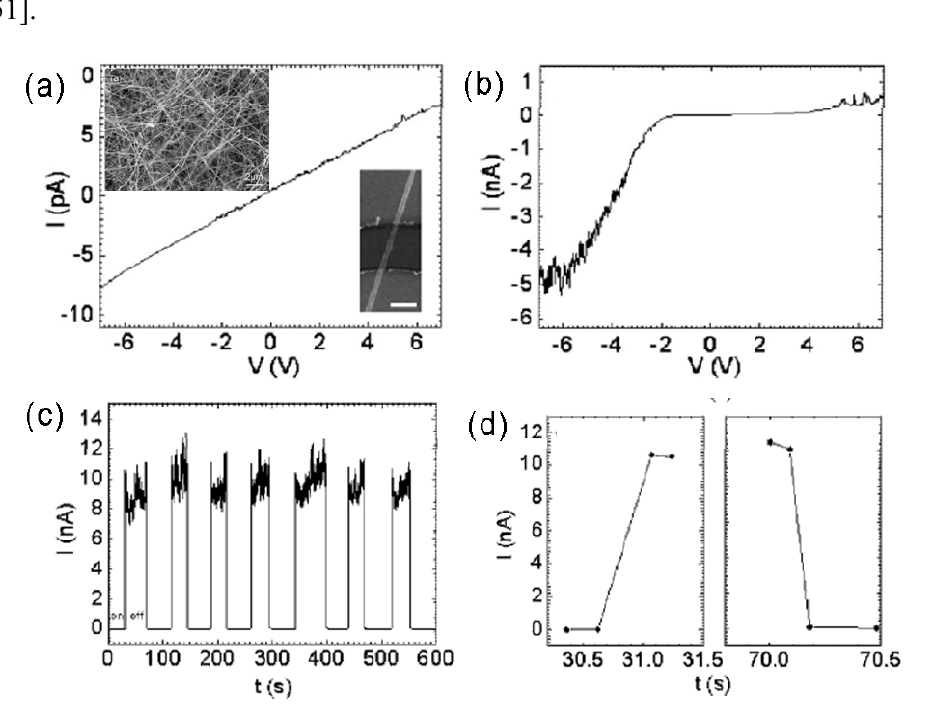
O NWs and the device; 2 3